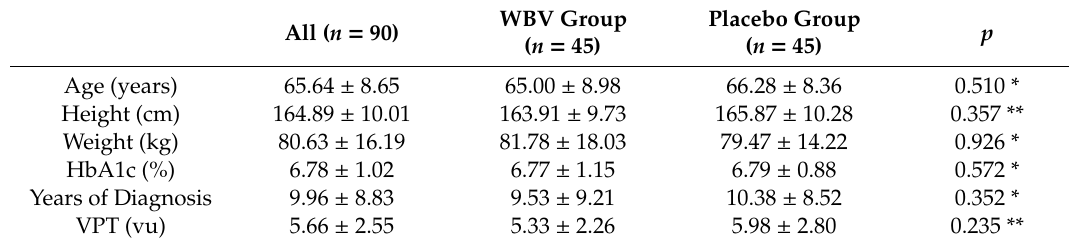
Table 2. Baseline characteristics of the study participants.